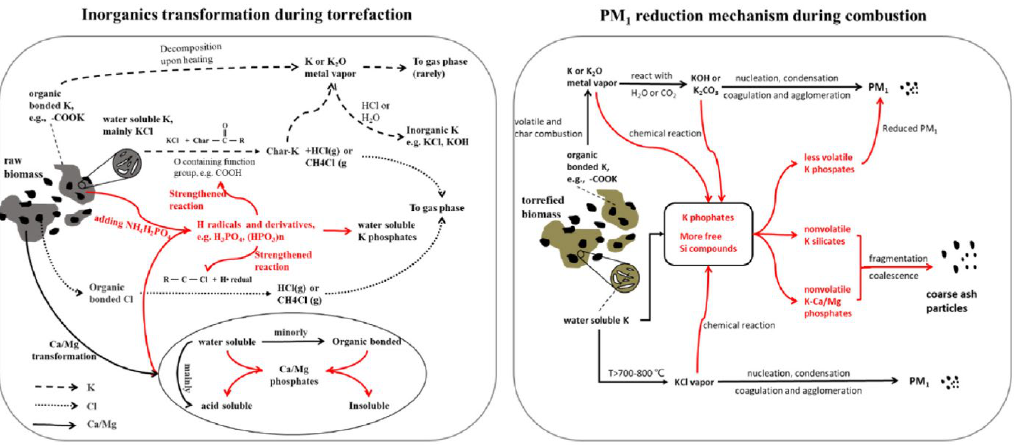
Figure 10. Schematic diagram of inorganics transformation during torrefaction, and PM 1 reduction mechanism during combustion. Adapted with permission from Ref. [132]. 2022, Elsevier. Table 2. Effects of additives on pellets.